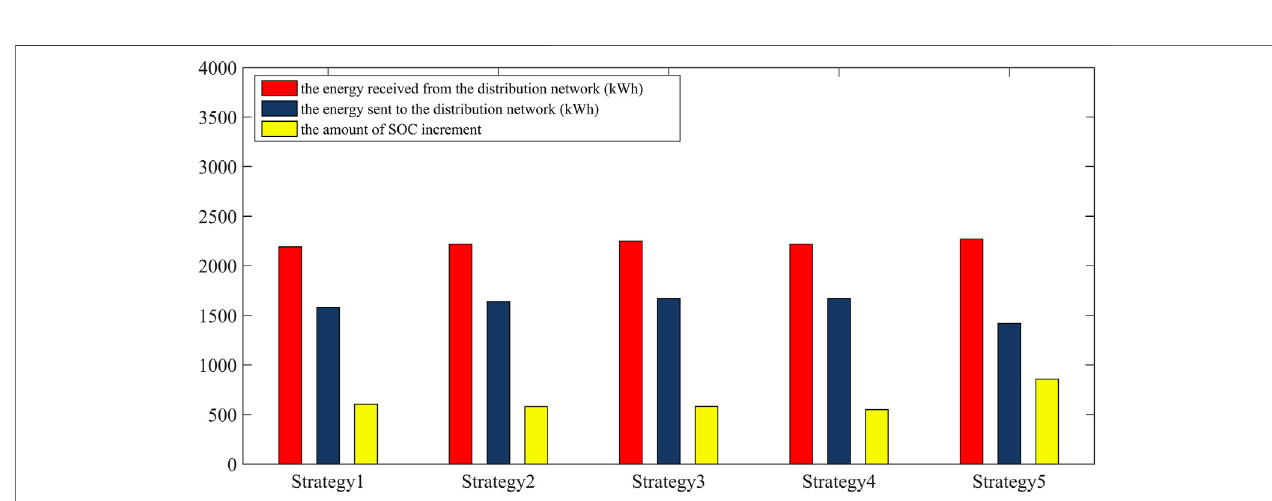
FIGURE 7 | Comparison of the amount of received energy from the grid, the amount of energy sent to the grid, and the amount of SOC increment in each of the strategies.